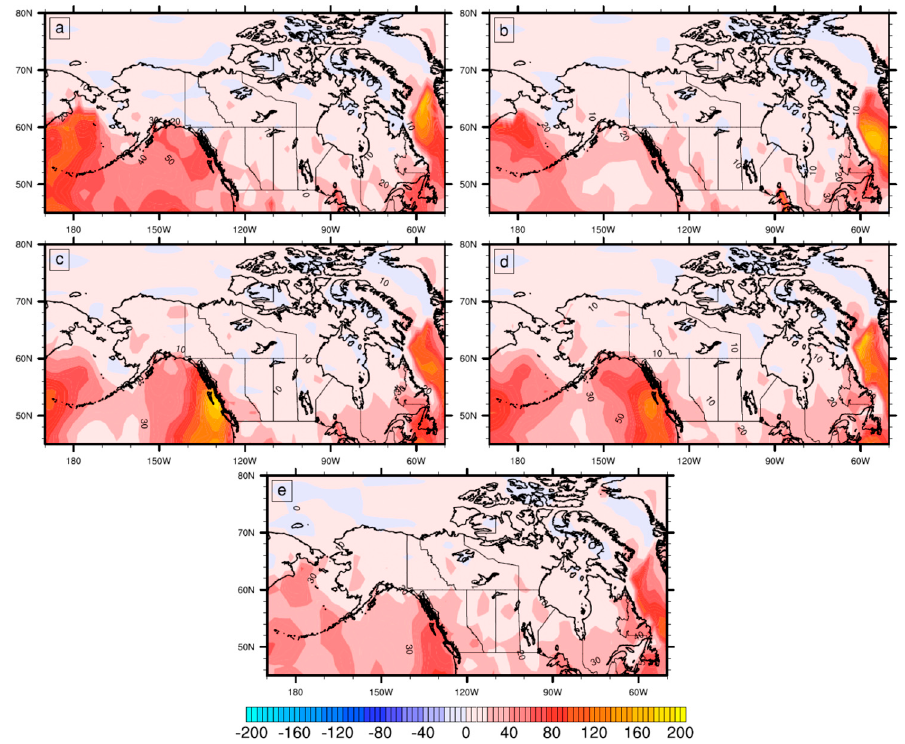
Figure 10. Latent Heat Flux (W m − 2 ) in ( a ) 1–15 January; ( b ) 16–31 January; ( c ) 1–14 February; ( d ) 15–28 February; ( e ) 1–11 March, 2019.